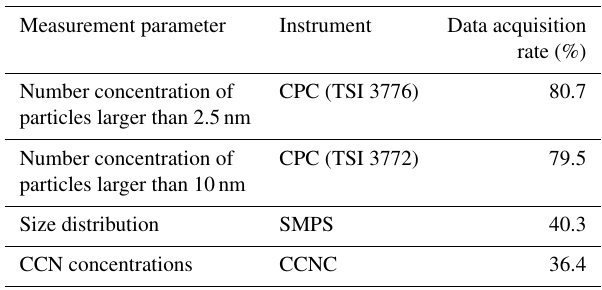
Table 1. Summary of data acquisition rate for each instrument dur- ing the analysis